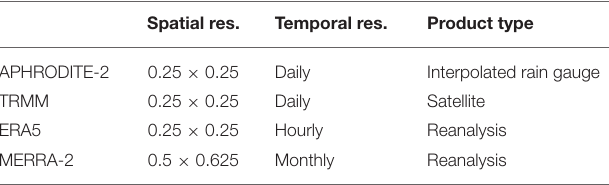
TABLE 1 | Summary of data products used in this analysis. Spatial